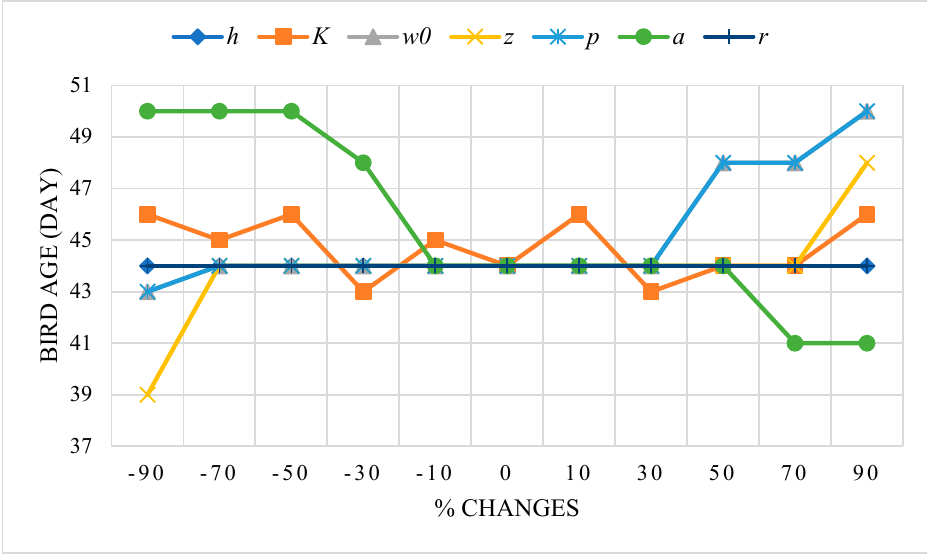
Figure 9. The effects of the parameter’s fluctuations on the optimal value of the slaughter age.